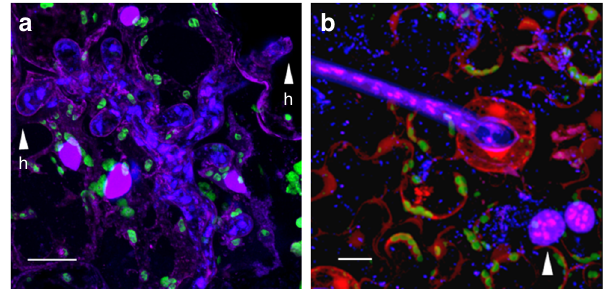
Fig. 8 The multinucleate architecture of B . lactucae . Lettuce cotyledons infected with B . lactucae stained with 4 ’ ,6-diamidino-2-phenylindole (DAPI) to render nuclear DNA fl uorescent. a Densely multinucleate coenocytic mycelium growing between spongy mesophyll cells of a non-transgenic lettuce cotyledon fi ve days post infection (dpi), prior to sporulation. Two of several multinucleate haustoria that have invaginated the host plasmalemma are indicated (h). The larger plant nuclei fl uoresce purple. Auto- fl uorescent chloroplasts are visualized as green. b Infected lettuce cotyledon stably expressing DsRED stained seven dpi at the onset of sporulation. The multinucleate stem of a sporangiophore is visible exiting a stoma. Two multinucleate spores are visible on the cotyledon surface (arrowed). Small DAPI-stained bacterial cells are also visible. Scale bars in each represent 15 μ